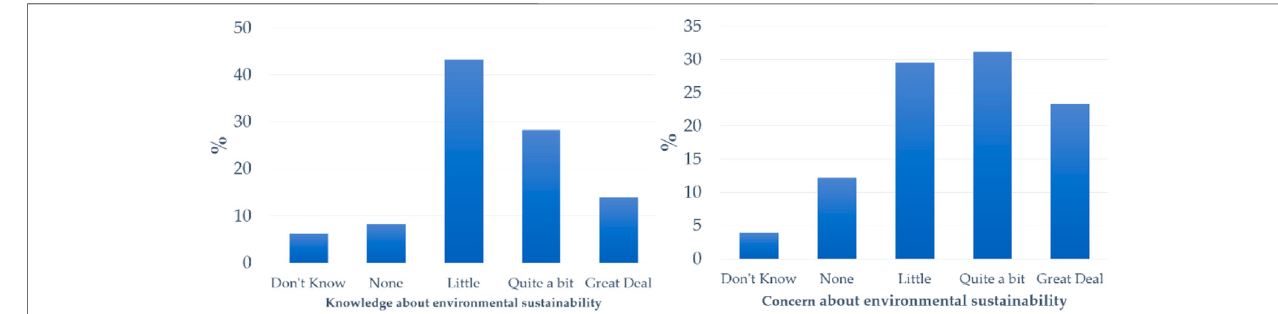
FIGURE 5 | Student ’ s awareness and concern about environmental sustainability.